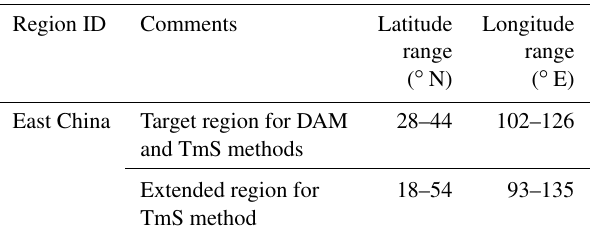
Table 3. Corner coordinates of the East China target region as anal- ysed in this study.